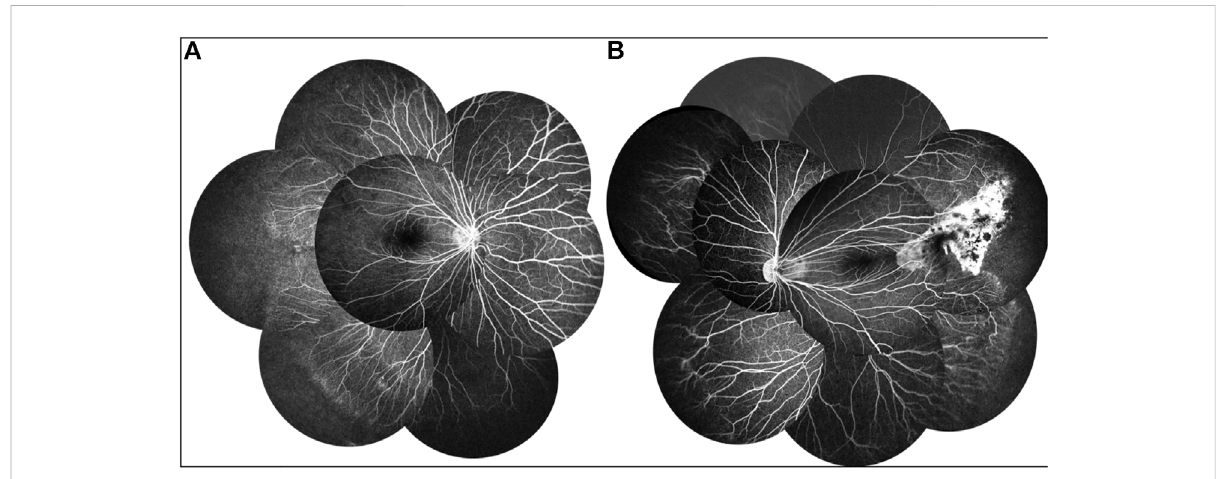
FIGURE 2 FFAoftheprobandshowedalargeavascularzoneinthebilateraltemporalperipheralretina, bloodvesselsintheperipheral retinalwere fl atand numerous, and the optic disc showed high fl uorescence inthelate stage of angiography (A,B) . The temporal peripheral retina of theleft eyeshowed patchy high fl uorescence with fl uorescein staining, but no obvious leakage (B) .